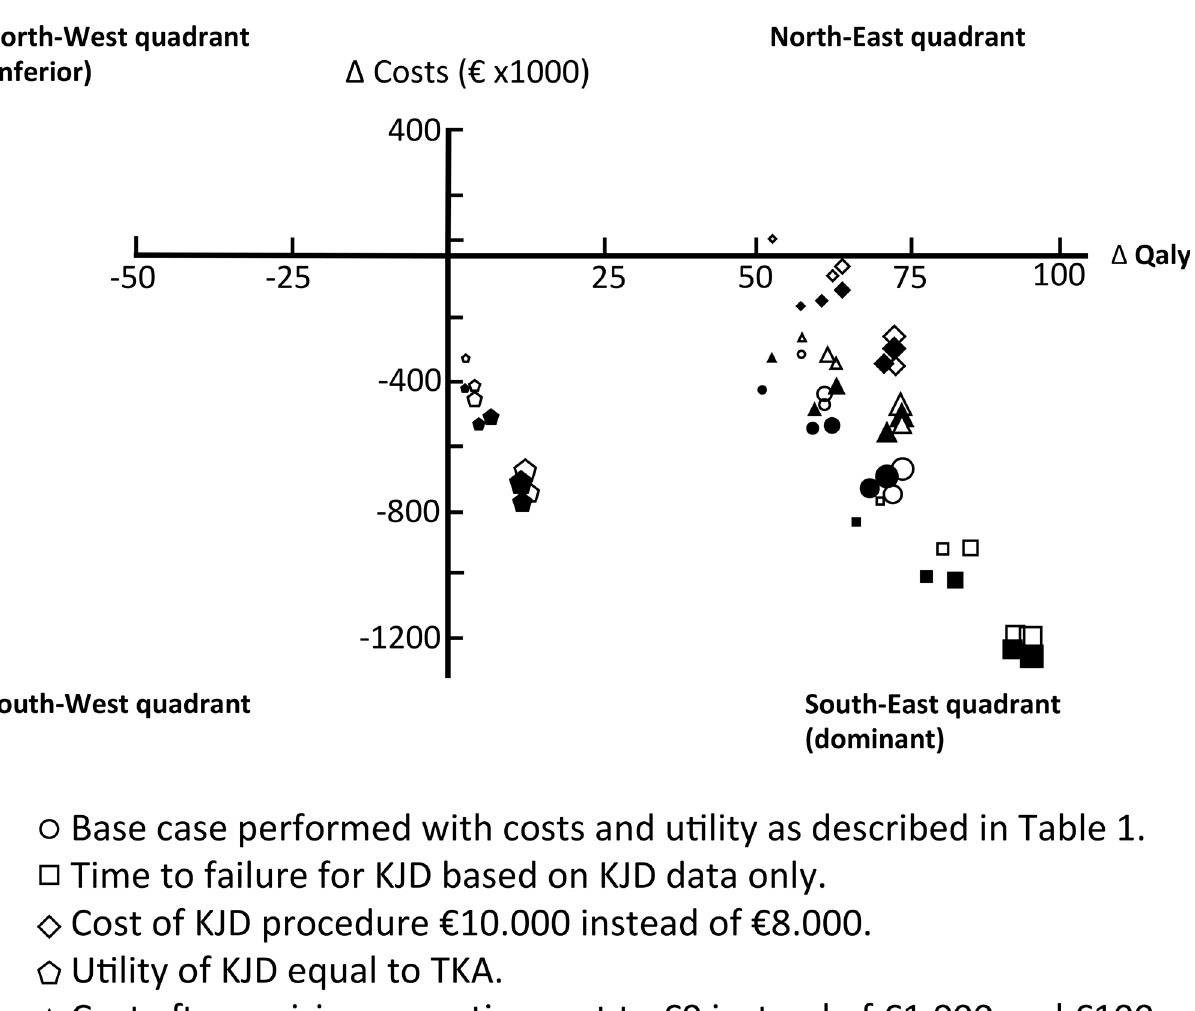
Fig 4. Deterministic sensitivity analyses. Females (open symbols) and males (filled symbols) per age category. The larger the symbol the younger the patient